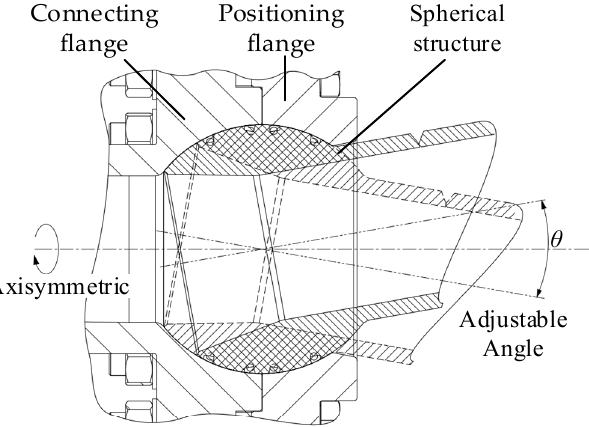
Figure 2. Diagram of the adjustable angle of the connector.